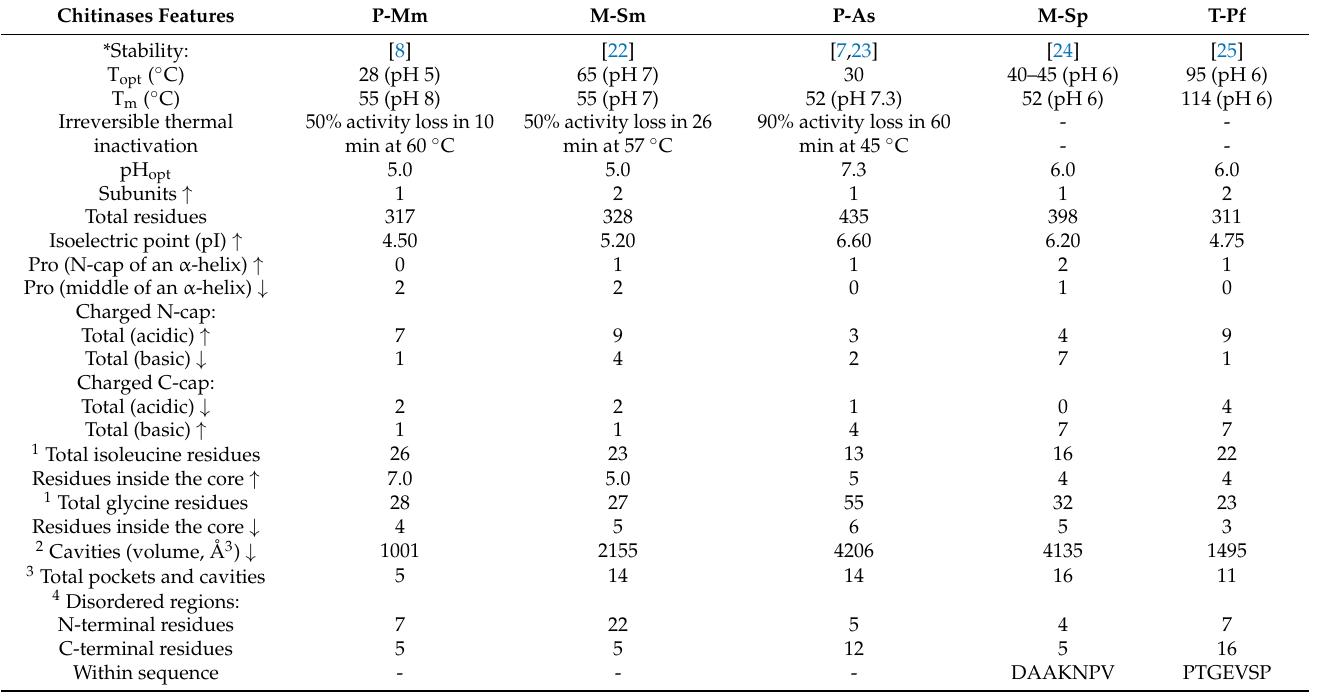
Table 1. Properties and compositional/structural features of thermally adapted